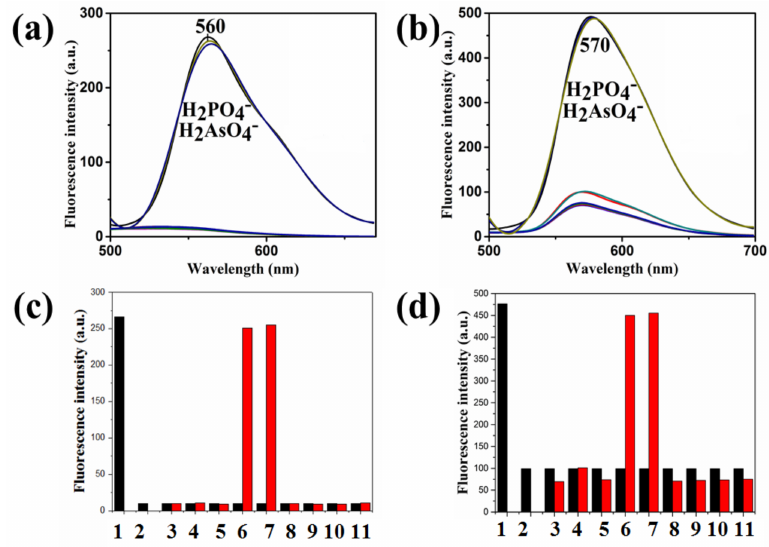
Figure 8. ( a ) and ( b ) Fluorescence spectra of 1 and 2 respectively in the presence of cyanide and interfering anions.: ( – 1 , – 1 + CN − , – N 3 − , – I − , – H 2 PO 4 − , – H 2 AsO 4 − , – F − , – SCN − , – Cl − , – Br − , – AcO − ), ( c ) and ( d ) bar grams fluorescence intensity change of 1 and 2 in the presence of cyanide and different anions.(1: 2 ; 2: 2 + CN − ; 3: SCN − ; 4: N 3 − ; 5: AcO − ; 6: H 2 AsO 4 − ; 7: H 2 PO 4 − ; 8: F − ; 9: Cl − ; 10: Br − ; 11: I −